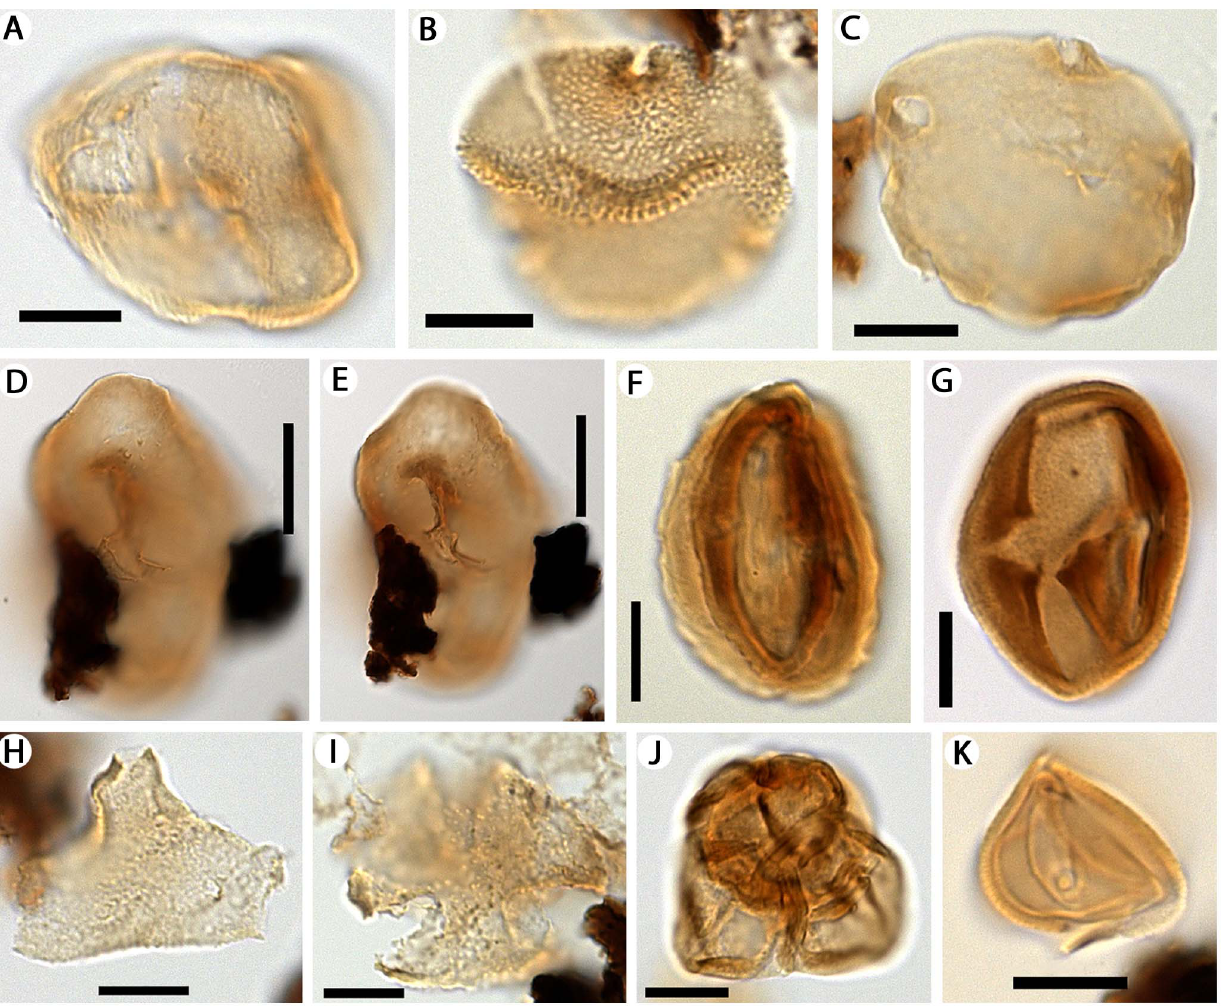
Figure 4. Microscope images of dicot pollen from the Rı´o Zeballos locality. Suggested extant affinities, if known, are shown in parentheses. A, Ailanthipites sp. (Anacardiaceae). B, Bombacacidites sp. (bombacoid Malvaceae). C, Stephanocolpites sp. (cf. Haloragaceae). D, E, Triprojectacites group cf. Integricorpus sp. (at two focal planes). F, Mutisiapollis sp. (Asteraceae). G, Tricolporites sp. H, Proteacidites sp. (Proteaceae). I, Spinitricolpites sp. J, Ericipites microverrucatus (Ericales). K, Schizocolpus sp. (Didymelaceae). Scale bars: A–C, F–K, 10 m m; D, E, 20 m